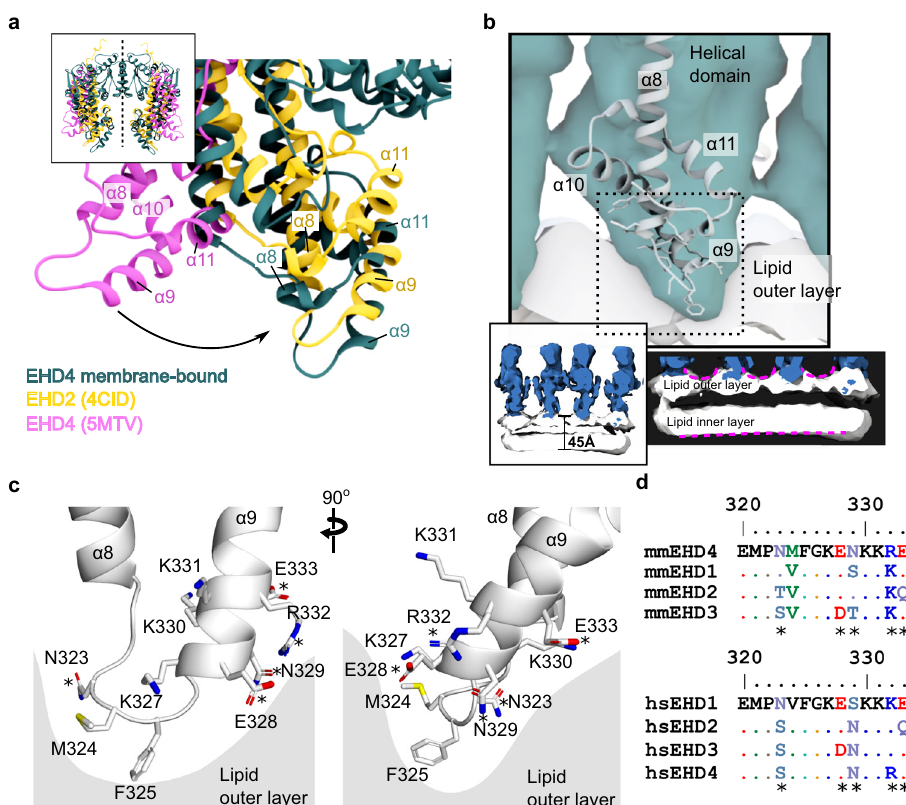
Fig. 4 | The membrane-binding mode of EHD4. a The cryo-ET model of EHD4 (teal) was superimposed with the G-domain on the crystal structures of EHD2 (yellow;pdbcode4CID)andEHD4(pink;pdbcode5MTV).Thecomparisonreveals that the membrane-bound structure adopts a closed conformation akin to EHD2. b Membrane-binding site of EHD4 inserts into the lipid outer layer. The two lower panelsshowhowthemembraneinteractionoftheEHD4 fi lamentsinducesbuckling of the lipid outer layer, as indicated by the magenta dotted line. c Membrane-